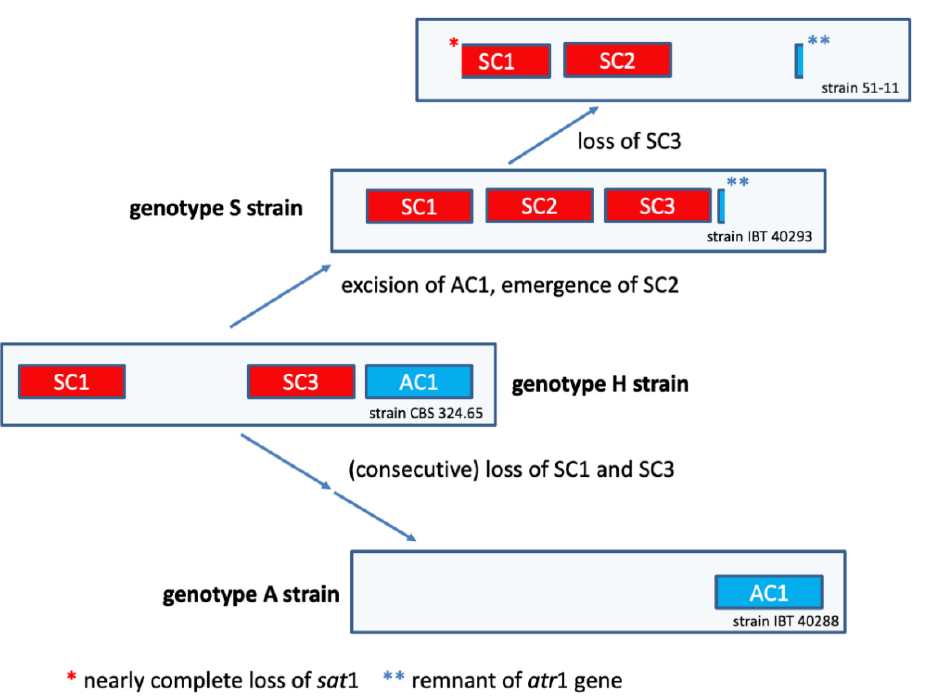
Figure 7. Current model of the evolution of the S. chartarum genotypes S, A, and H. The different gene clusters are depicted as boxes. The size and the position of these boxes do not represent the correct size and position of the respective cluster in the genome. Satratoxin gene clusters are shown in red and atranone gene clusters in blue.